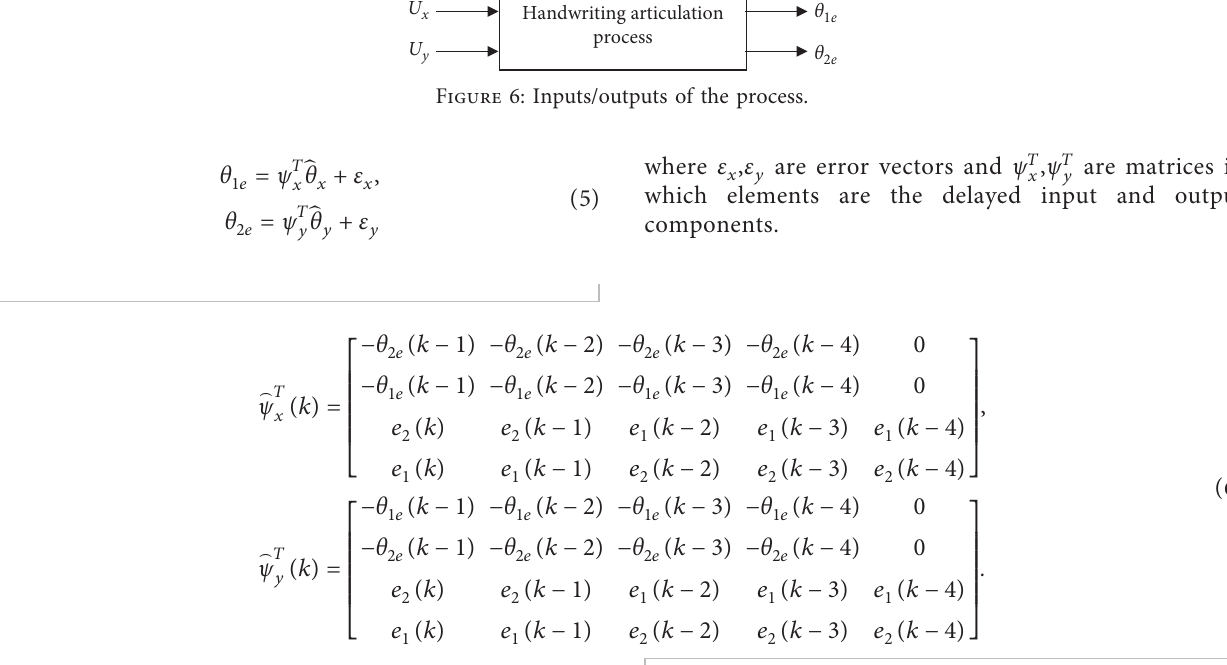
Figure 6: Inputs/outputs of the